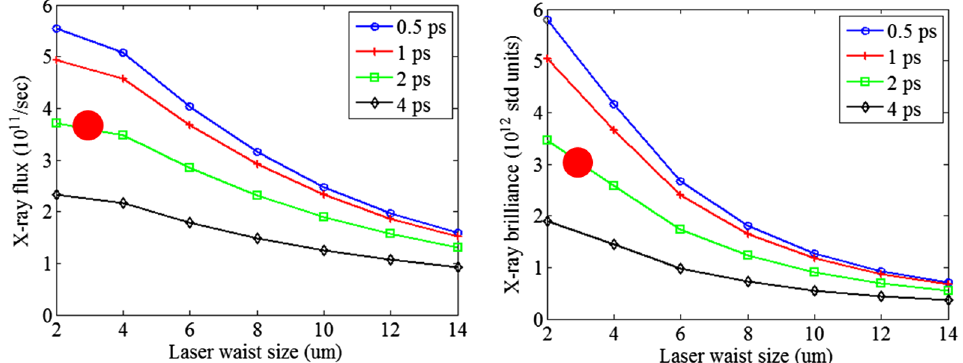
FIG. 6. Plots of flux (left) and brilliance (right) as a function of 1 =e 2 laser focus size w 0 . Each curve represents a different laser FWHM pulse length from 0.5 to 4 ps. The red circle in each plot marks the design operating point, which is an optimization of laser gain and bandwidth, average power, and peak